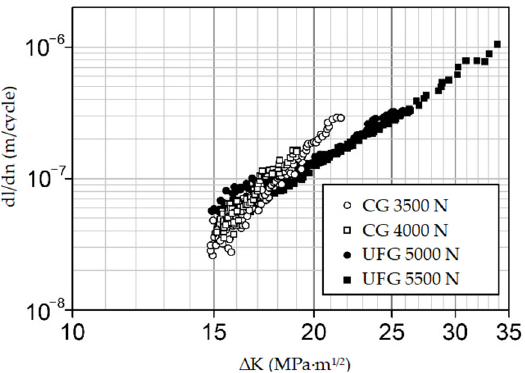
Figure 7. Straight-line portion of the kinetic diagrams of fatigue fracture for the steel in the initial state (bright dots) and after ECAP (dark dots). Table 6. Paris equations describing the straight-line portion of the kinetic diagrams of fatigue fracture for the steel after different types of treatment.